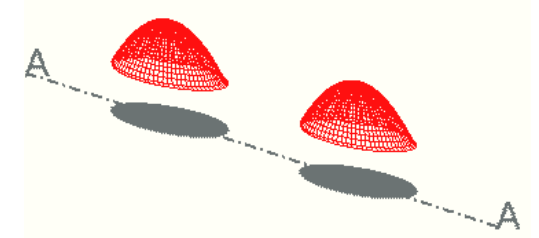
Figure 35: Uniform load distribution over the two elliptical tire- ground contact areas (the A-A vertical section is taken along the cross-section of the twin wheel).